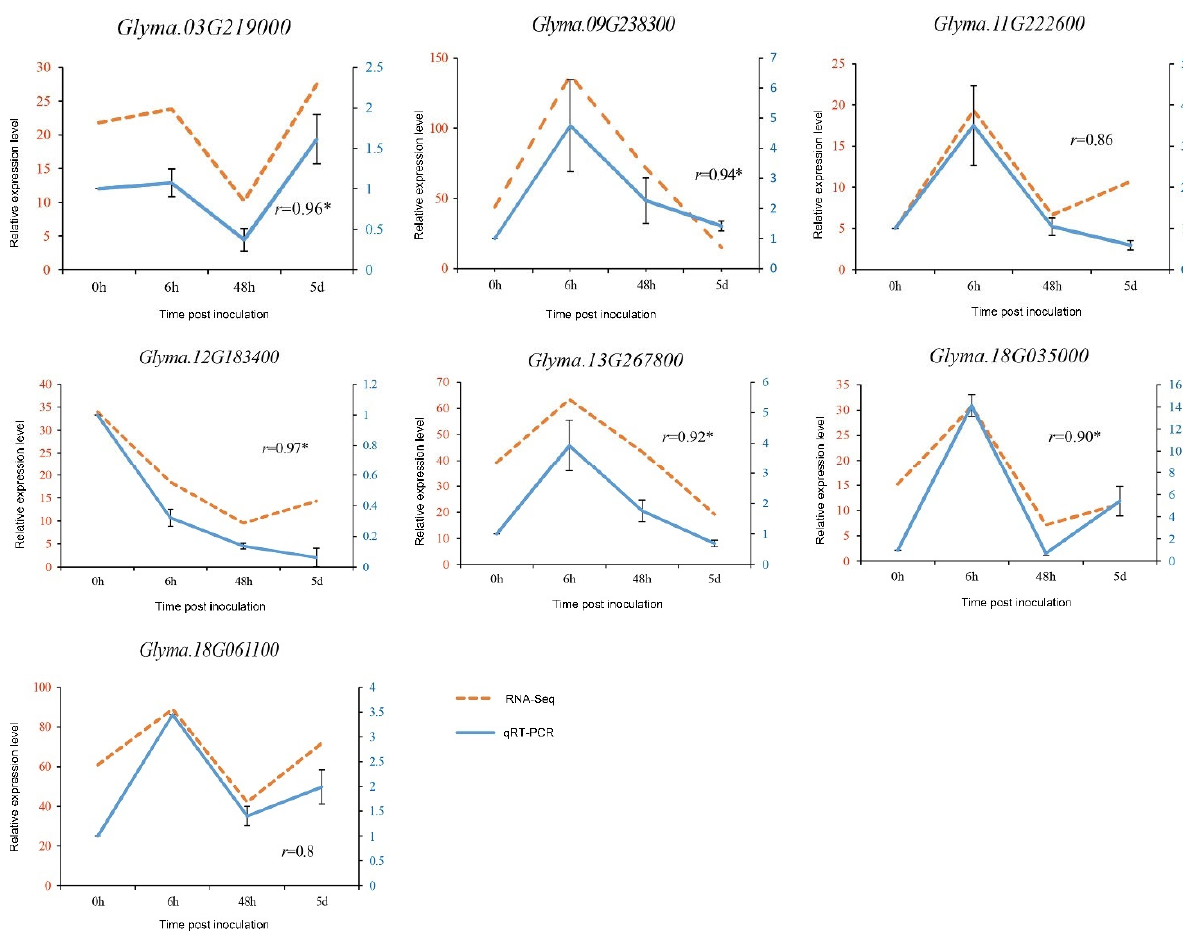
Figure 5. Comparison of the relative expression level change of 7 selected DEGs by qRT-PCR and RNA-Seq (susceptible variety NN1138-2, left vertical axis coordinate is FPKM of RNA-Seq (orange); right vertical axis coordinate is relative expression level of qRT-PCR (blue); r -values are the correlation coefficients between qRT ‐ PCR and RNA ‐ seq, * indicates significant correlation).